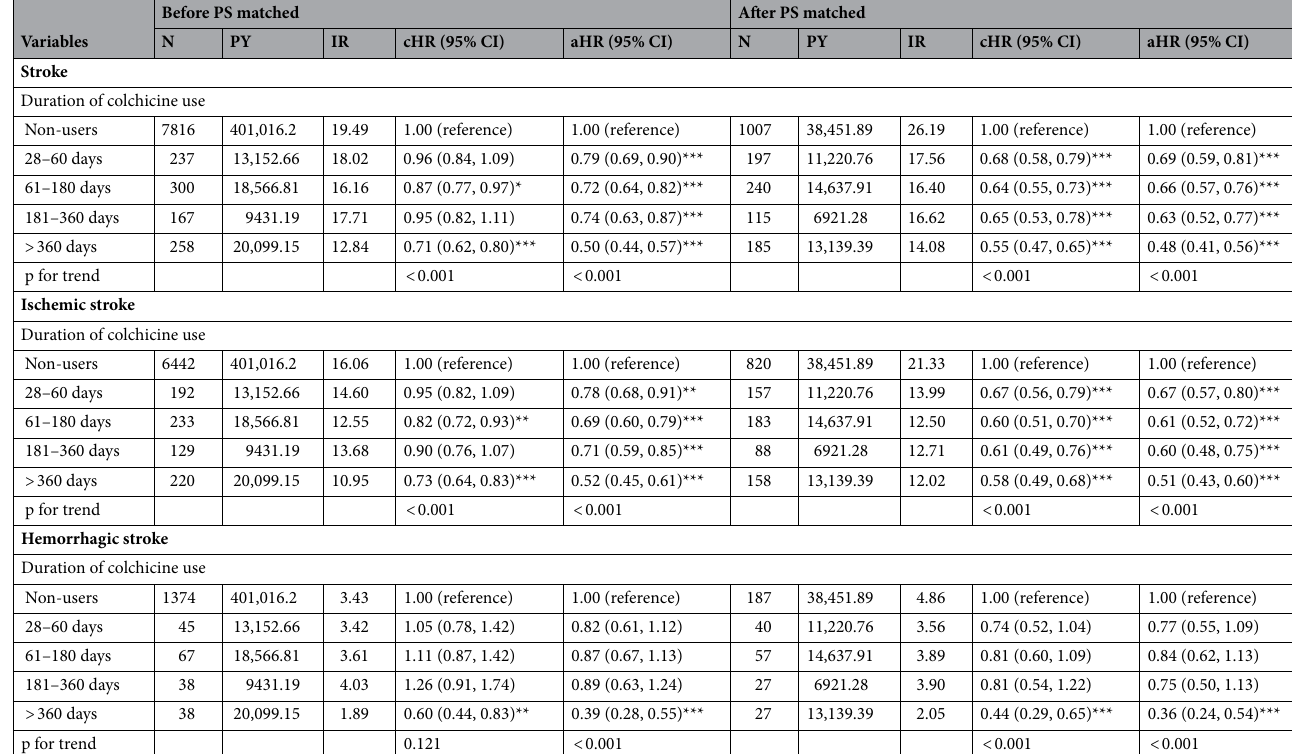
Table 4. Hazard ratio and 95% CI for stroke associated with total duration of colchicine use. aHR adjusted for age, sex, hypertension, hyperlipidemia, hypoglycemia, obesity, gout, pneumonia, hepatitis B, hepatitis C, liver cirrhosis, Allopurinol, Benzbromarone, nsaid, Oralsteroid, Antithrombotic, adapted Diabetes Complications Severity Index, aDCSI and inpatient day. PS, propensity score; N, number of event; PY, person-years; IR, incidence rate, per 1000 person-years; cHR, crude hazard ratio; aHR, adjusted hazard ratio; CI, confidence interval. *p < 0.05, **p < 0.001, ***p <